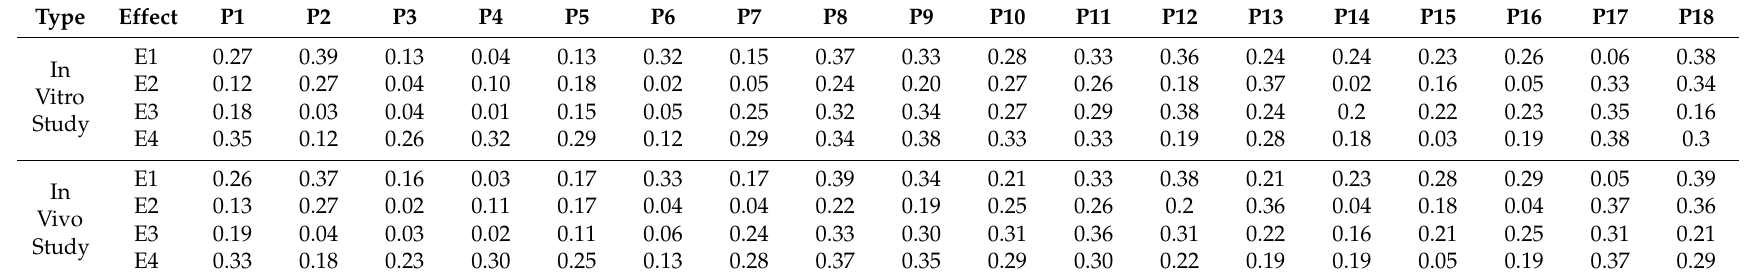
Table 6. The coefficients values of the eighteen components (P1–P18) of ten different batches of panax ginseng saponins extracts in vitro and in vivo study in example 2. Type In